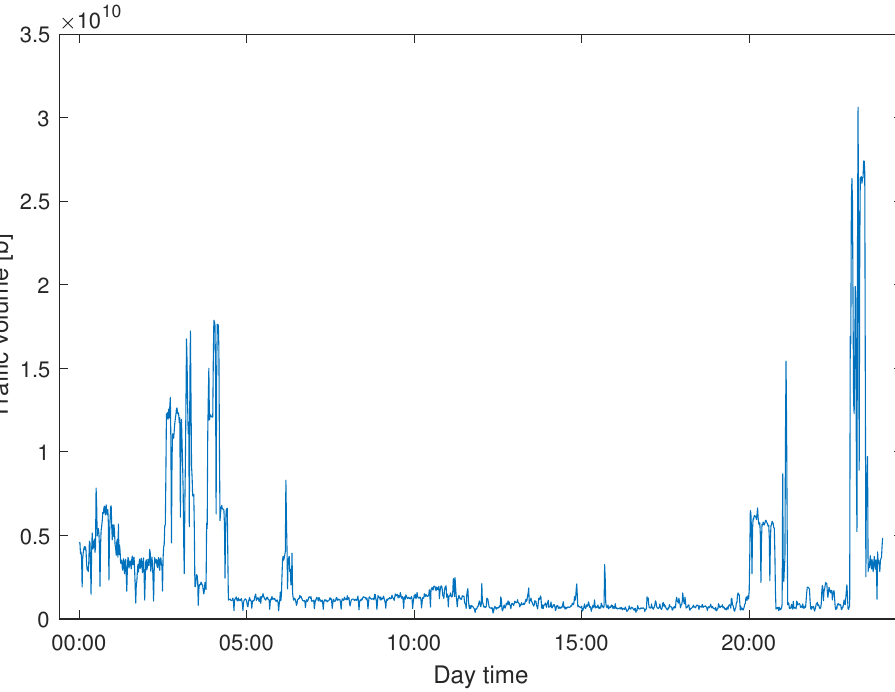
Figure 1. WASK dataset presentation: traffic observed on 1 January 2021.